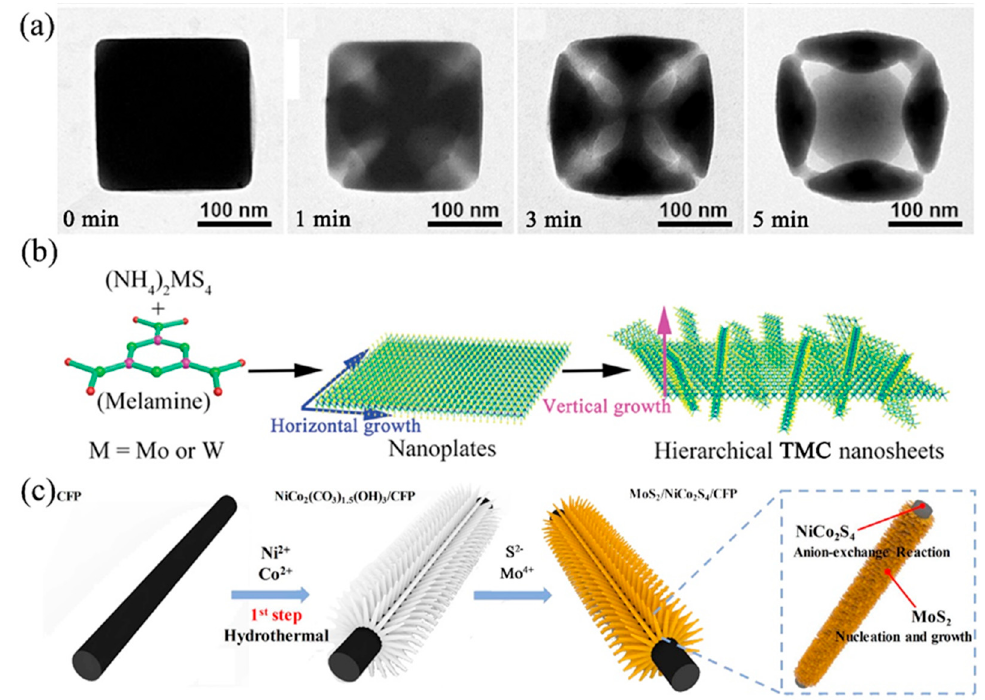
Figure 5. ( a ) The evolution of hierarchical Ni-Fe-Se nanocages prepared via chemical etching.